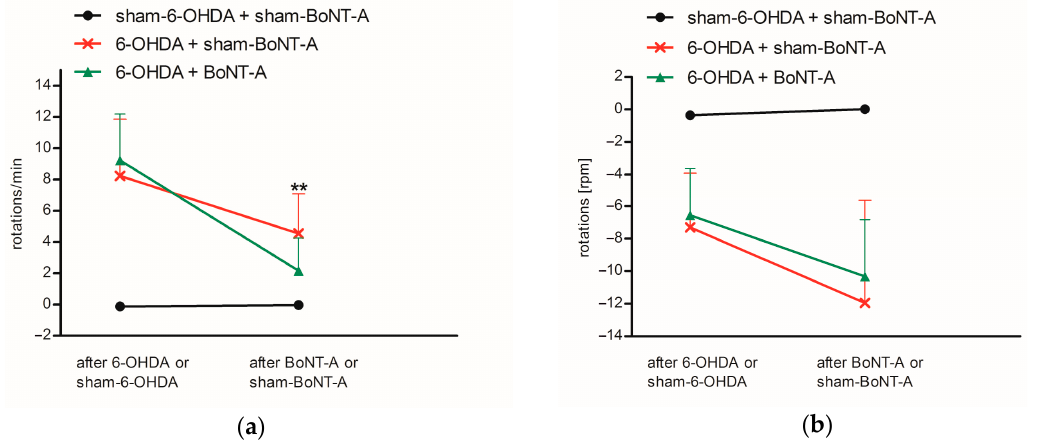
Figure 2. Results of the rotational behavior in ( a ) apomorphine- and ( b ) amphetamine-induced testing for controls (sham-6-OHDA + sham-BoNT-A), sham-injected hemi-PD rats (6-OHDA + sham-BoNT-A) and BoNT-A-injected hemi-PD rats (6-OHDA + BoNT-A) displayed after 6-OHDA or sham-6-OHDA and BoNT-A or sham-BoNT-A injection. Rotations contralateral to the injection side (clockwise) are displayed with negative algebraic signs, anti-clockwise rotations with positive algebraic signs. Controls did not demonstrate designated rotational behavior, hemi-PD rats exhibited strong asymmetric drug-induced rotations that were almost completely abolished after BoNT-A injection in apomorphine testing and slightly abolished in amphetamine testing. Significance is displayed as ** p < 0.01.